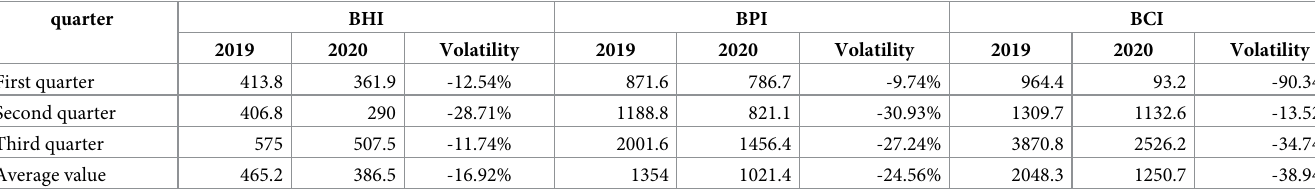
Table 9. Comparison of market performance of different ship types before and after the COVID-19 pandemic. quarter BHI BPI